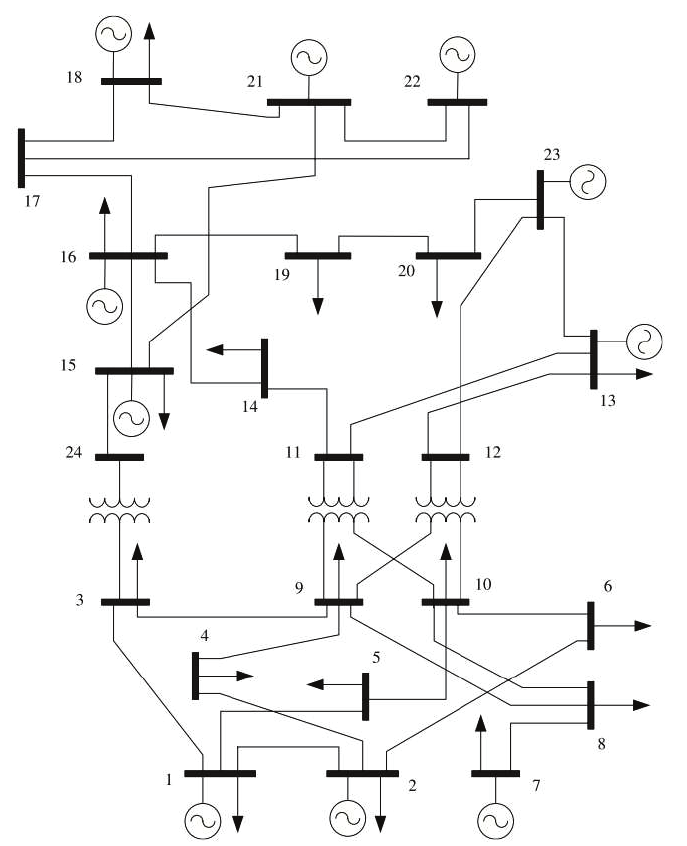
Figure 9. IEEE-24 bus test